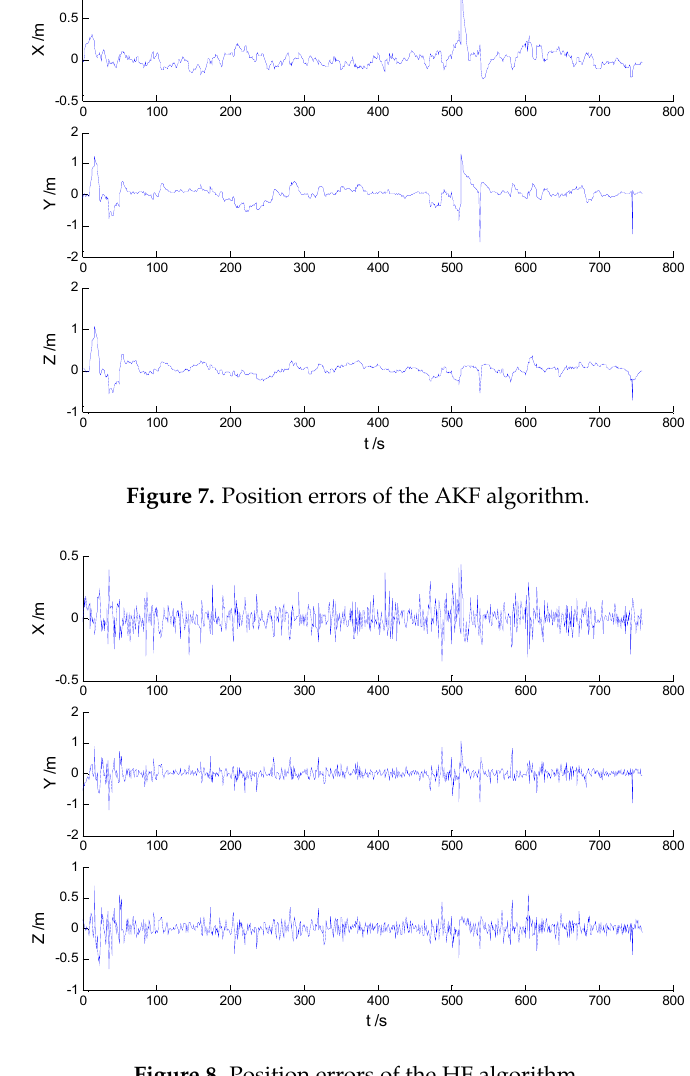
Figure 9. Position errors of the AHF algorithm.